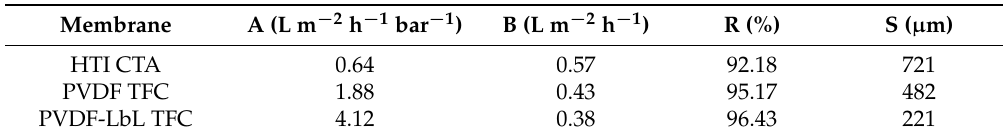
Table 2. The membrane intrinsic transport properties of the PVDF TFC, PVDF-LbL TFC, and commercial CTA